Question: What style of plot is this figure drawn as?
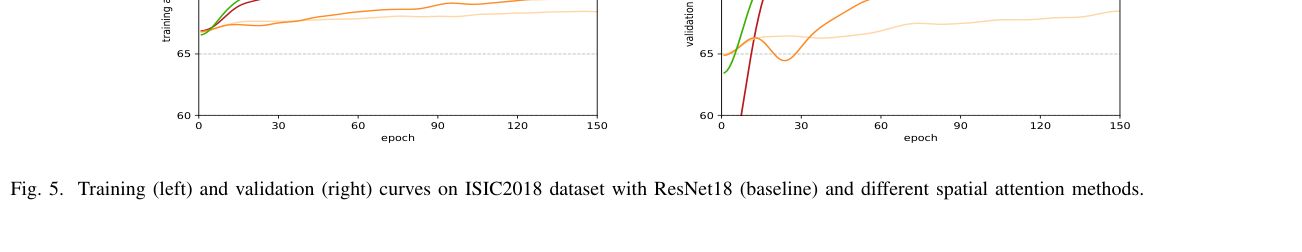
Answer: line